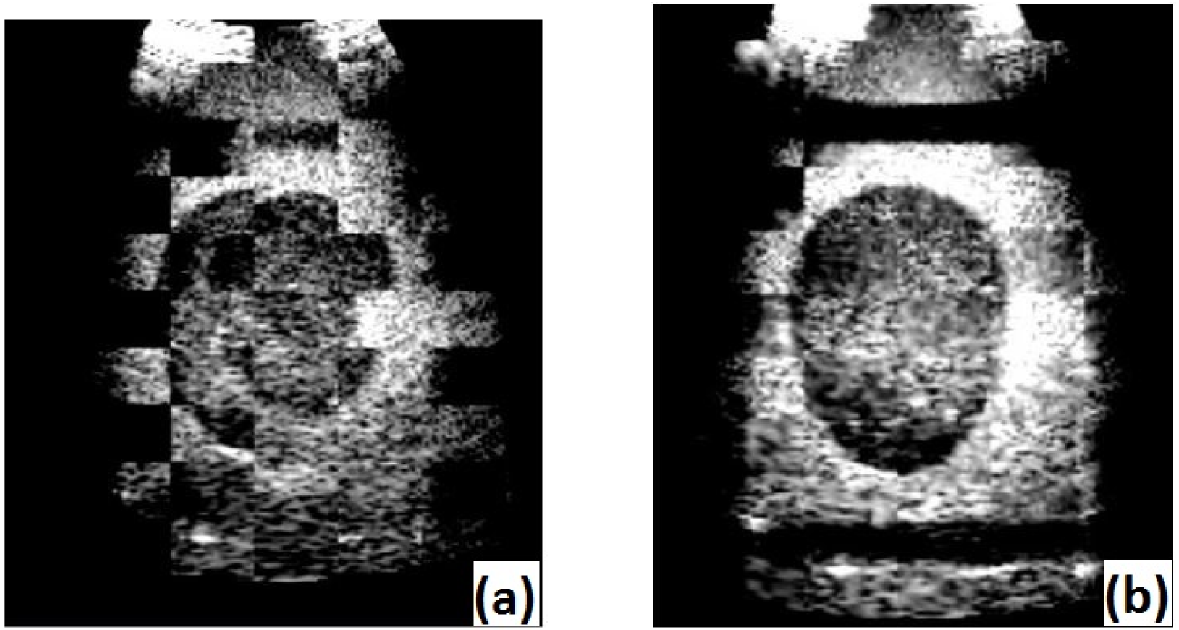
Fig 8. Checkerboard image of egg phantom images with 3D Slicer . On the left hand side, the unaligned images can be seen, on the right hand side the images after alignment using the US calibration are overlaid.